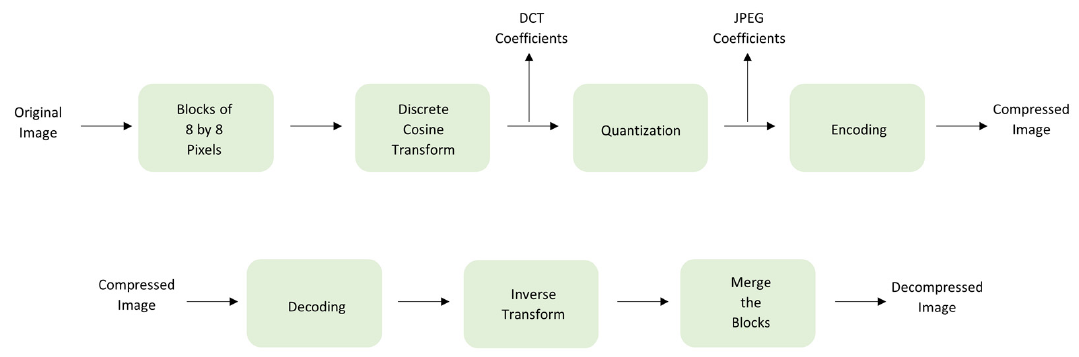
Figure 2. Obtaining a JPEG compressed image.